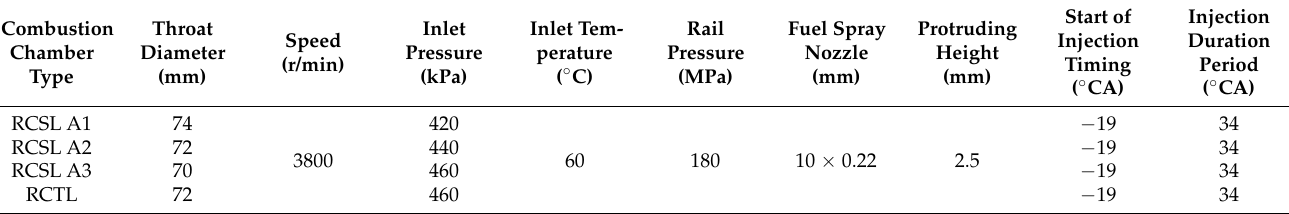
Table 4. Experimental schedule for different combustion